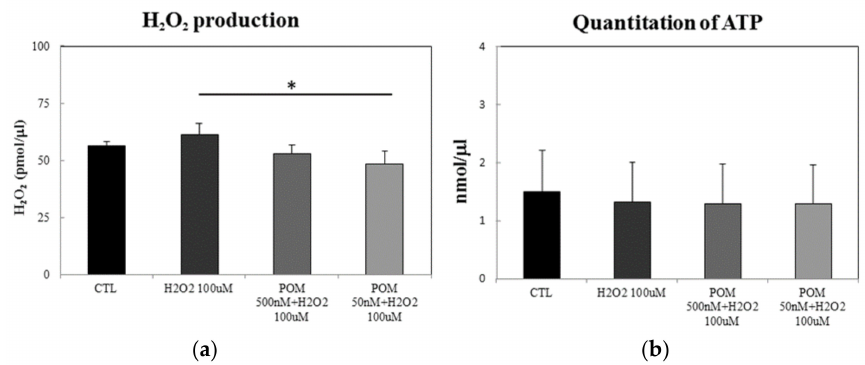
Figure 2. Effects of pomalidomide (POM) on H 2 O 2 -induced oxidative stress and adenosine triphosphate (ATP) levels. ( a ) The OxiRed Probe reacts with H 2 O 2 to produce red fluorescence (Ex/Em = 535/587 nm). The results represent the mean ± standard error of the mean (SEM, n = 3). There was a statistically insignificant trend of elevated H 2 O 2 amount in media in the H 2 O 2 alone challenged group. Addition of POM 50 nM reversed this, with * p < 0.05 versus 100 µ M H 2 O 2 alone treated group. ( b ) The ATP assay kit utilizes the phosphorylation of glycerol to generate a product and is quantified by fluorometric method (Ex/Em = 535/587 nm). There were no significant differences among groups (mean ± SEM, n = 3).